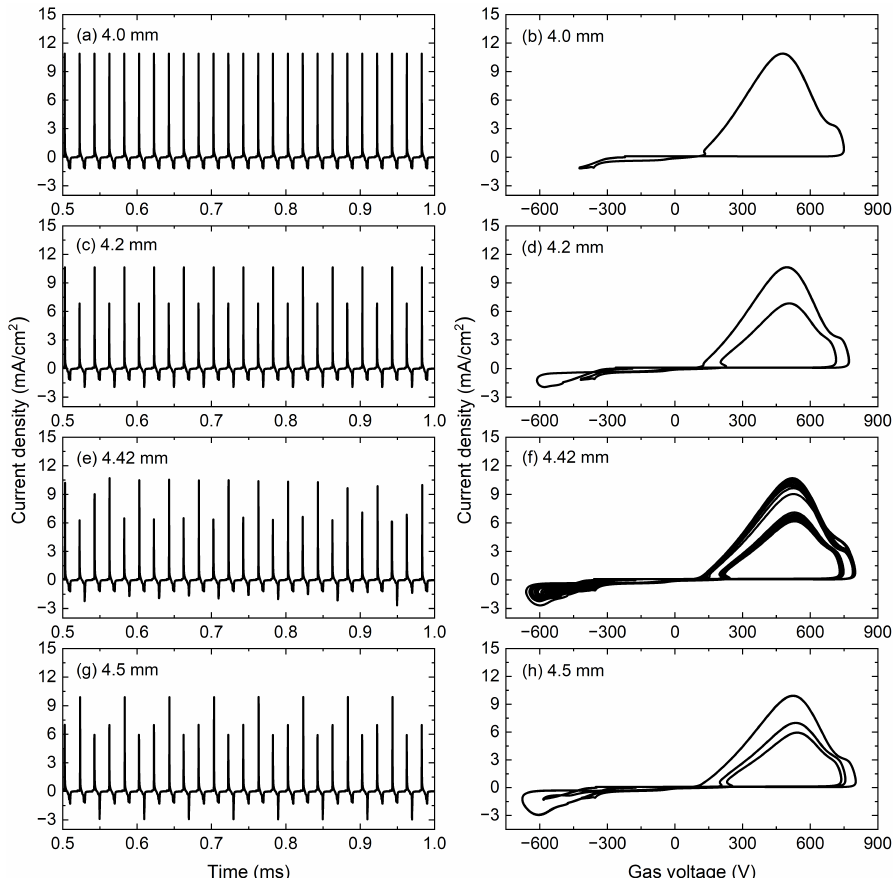
Figure 2. Temporal evolutions of discharge current density with the gap widths of 4.0 mm ( a ), 4.2 mm ( c ), 4.42 mm ( e ), and 4.5 mm ( g ), together with the corresponding trajectories in phase space with the gap widths of 4.0 mm ( b ), 4.2 mm ( d ), 4.42 mm ( f ), and 4.5 mm ( h